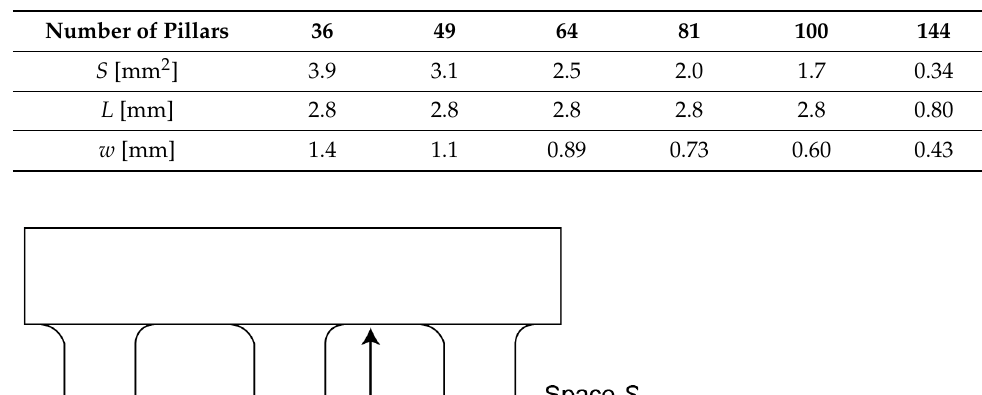
Figure 3. Design of CMEs. All CMEs have a square shape with a width of 10 mm. The number of pillars determines the gap width 𝑤 (see Table 1). The diameter of the pillars is 0.4 mm.